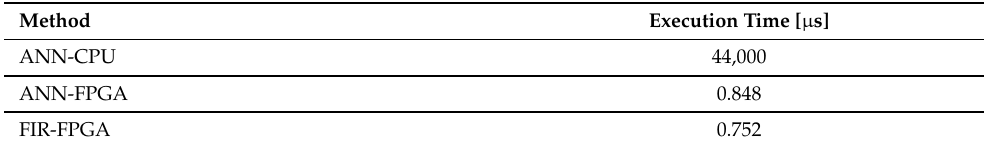
Table 5. Execution time comparison among artificial neural networks (ANNs) using CPU, FPGA and the FIR correlation method.